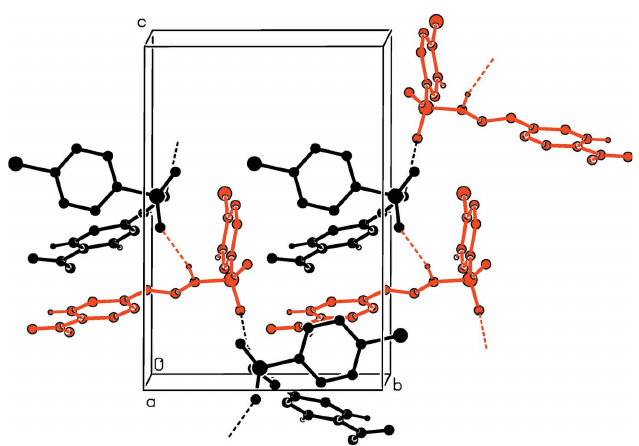
Figure 4 A partial view along the a axis of the crystal packing of (II), with hydrogen bonds (Table 3) shown as dashed lines. H atoms not involved in these interactions have been omitted. Colour code: black A molecules; red B molecules. Figs. 4 and 5). The N—H (cid:4) (cid:4) (cid:4) O hydrogen bond involving the sulfonyl O atom and the amino H atom of the hydrazide segment between the A and B molecules results in the formation of – A – B – A – B – chains propagating along the c -axis direction (Fig. 4). The chains are linked by C—H (cid:4) (cid:4) (cid:4) O inter- actions involving O atoms O4 in (II A ) and O5 in (II B ) and O7 of the nitro group and the aromatic hydrogen atoms ortho to the Cl or NO group. The sulfonyl O atom of (II B ), i.e. O5, 2